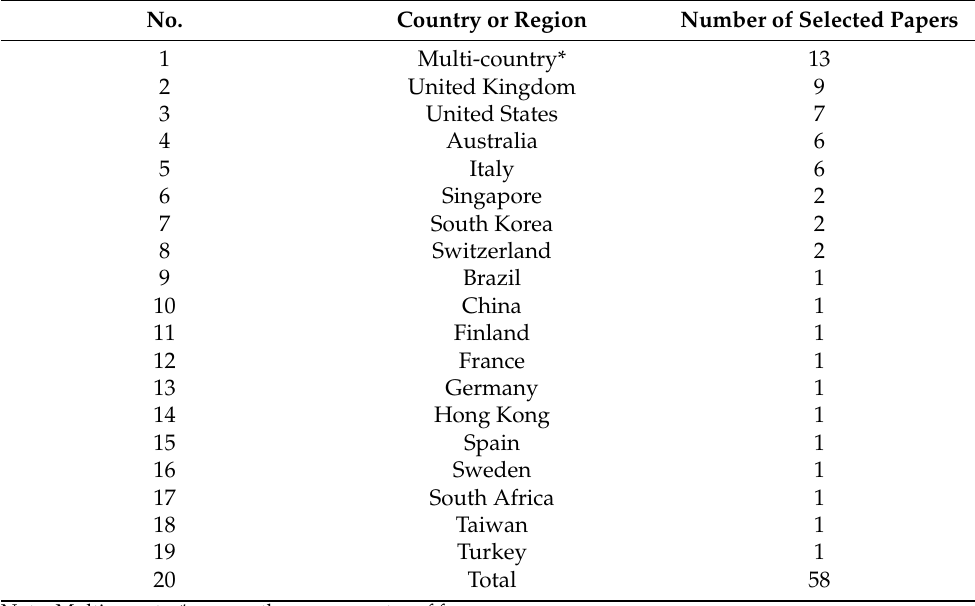
Table 2. Distribution of selected papers by country or region.